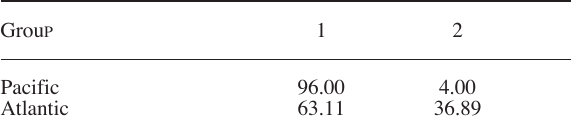
F IG . 2. – First two axes of the transformed data (normalization of individuals of each group) with the correspondence analysis (CA) using all the morphometric variables for Mugil curema . Key: Circles= Pa: Pacific coast; Triangles= Atl: Atlantic coast. White = Fe: females; Grey = Ma: males. Rhombus= Variables. T ABLE 3. – Factorial matrix of the CA with the normalized data for all the variables. Variable